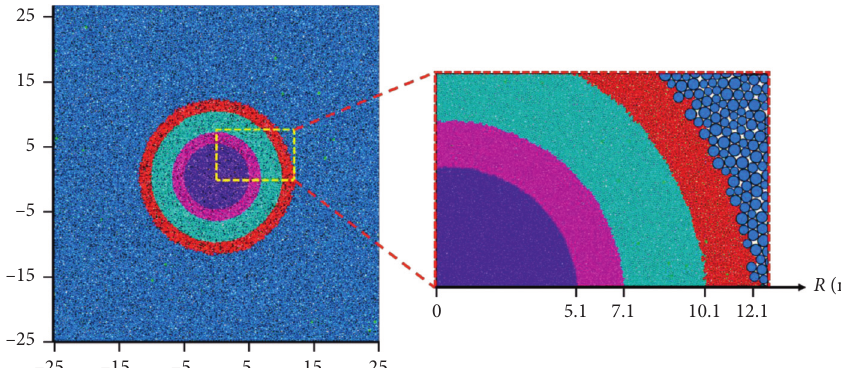
Figure 20: Particle distribution of the